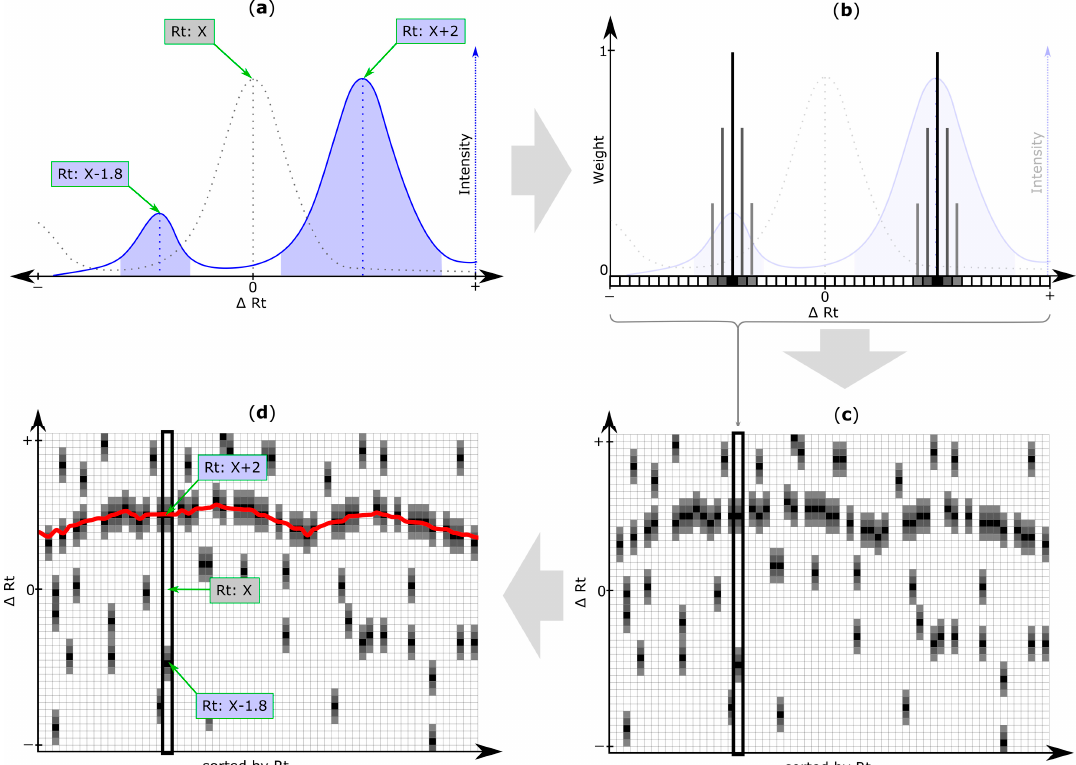
Figure 3. Retention time (Rt) shift detection procedure: ( a ) Extracted ion chromatogram (EIC) of a target chromatogram (blue solid line) with two chromatographic peaks (blue areas) and their peak apexes or centers (blue dotted line), depending on the selected peak picking algorithm.